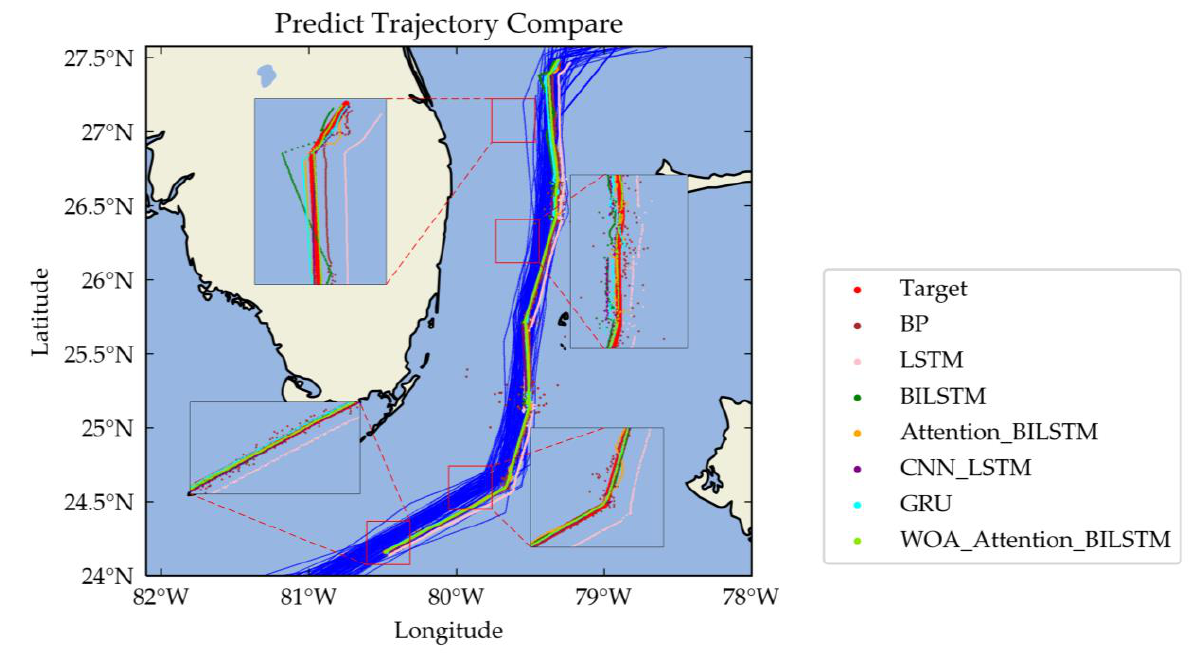
Figure 12. The visualization and comparison of the models’ prediction results.